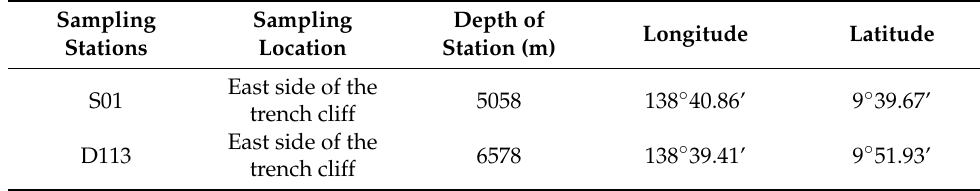
Table 1. Sampling stations and their